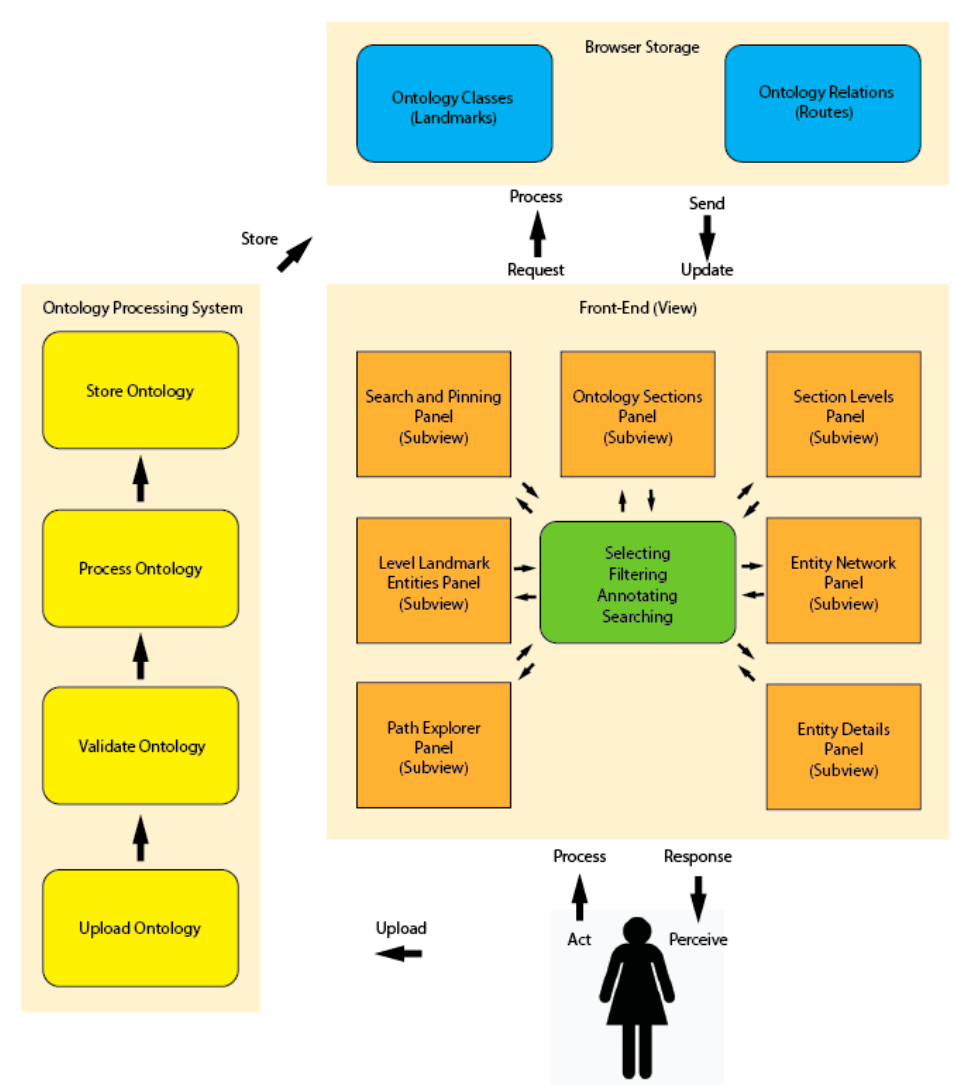
Figure 7. Depiction of the workflow of PRONTOVISE (PRogressive ONTOlogy VISualization Explorer). Yellow boxes represent the processes performed within the back-end computation system. Blue boxes represent the object types which are persisted within browser storage. Orange boxes represent the various subviews within the front-end visualization system. The green box represents the types of low-level interactions which can be made to the system.